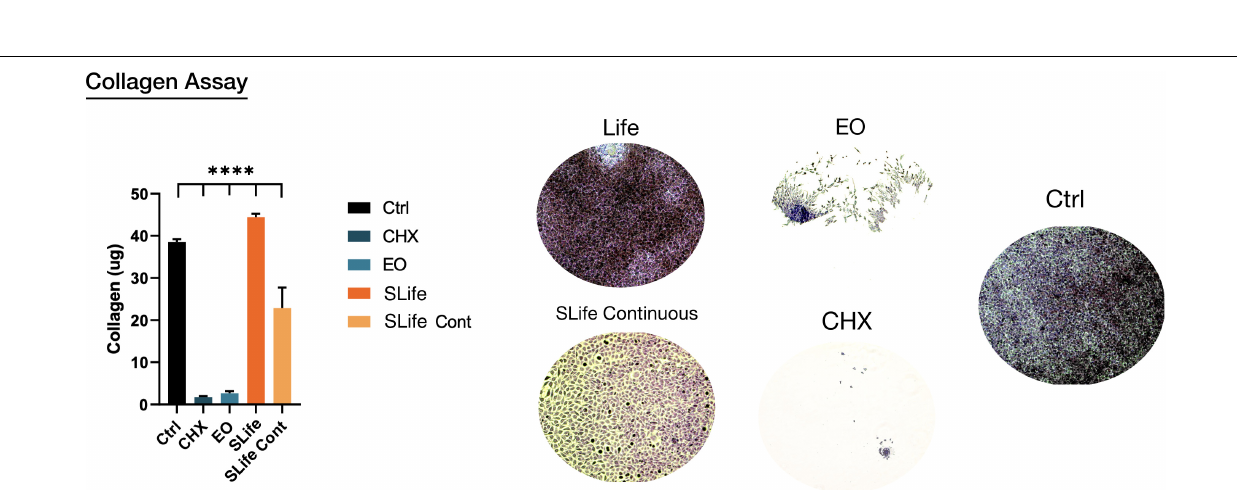
Frontiers in Physiology |